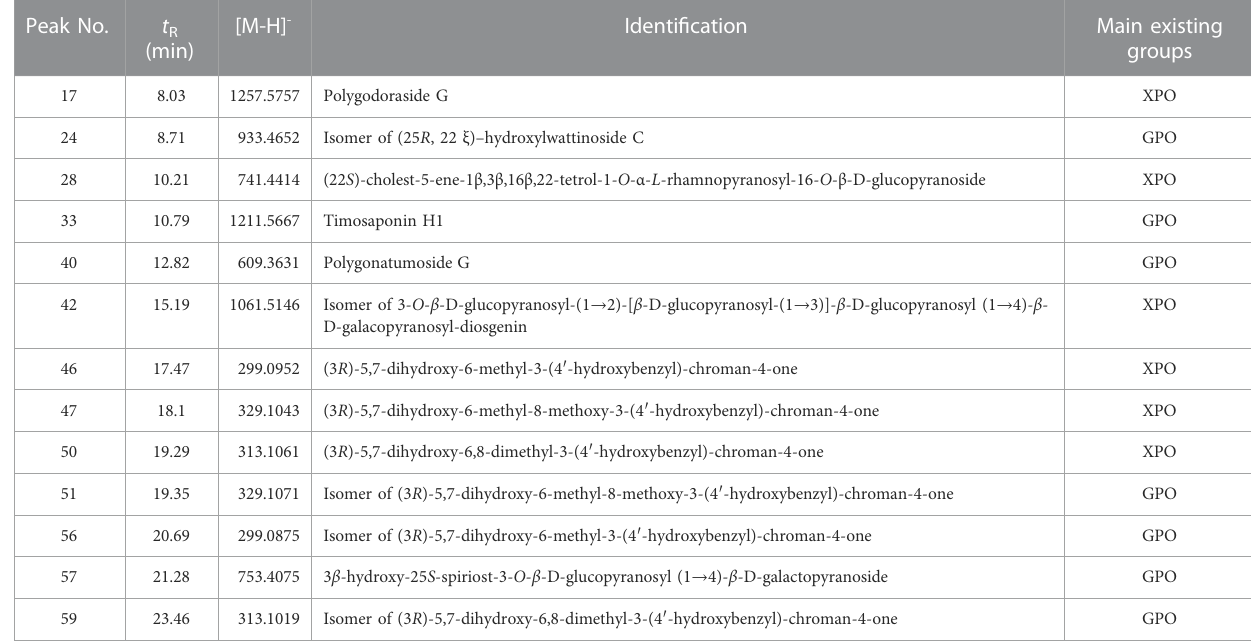
TABLE 1 Selected markers responsible for discriminating two commercial speci fi cations of PO. Peak